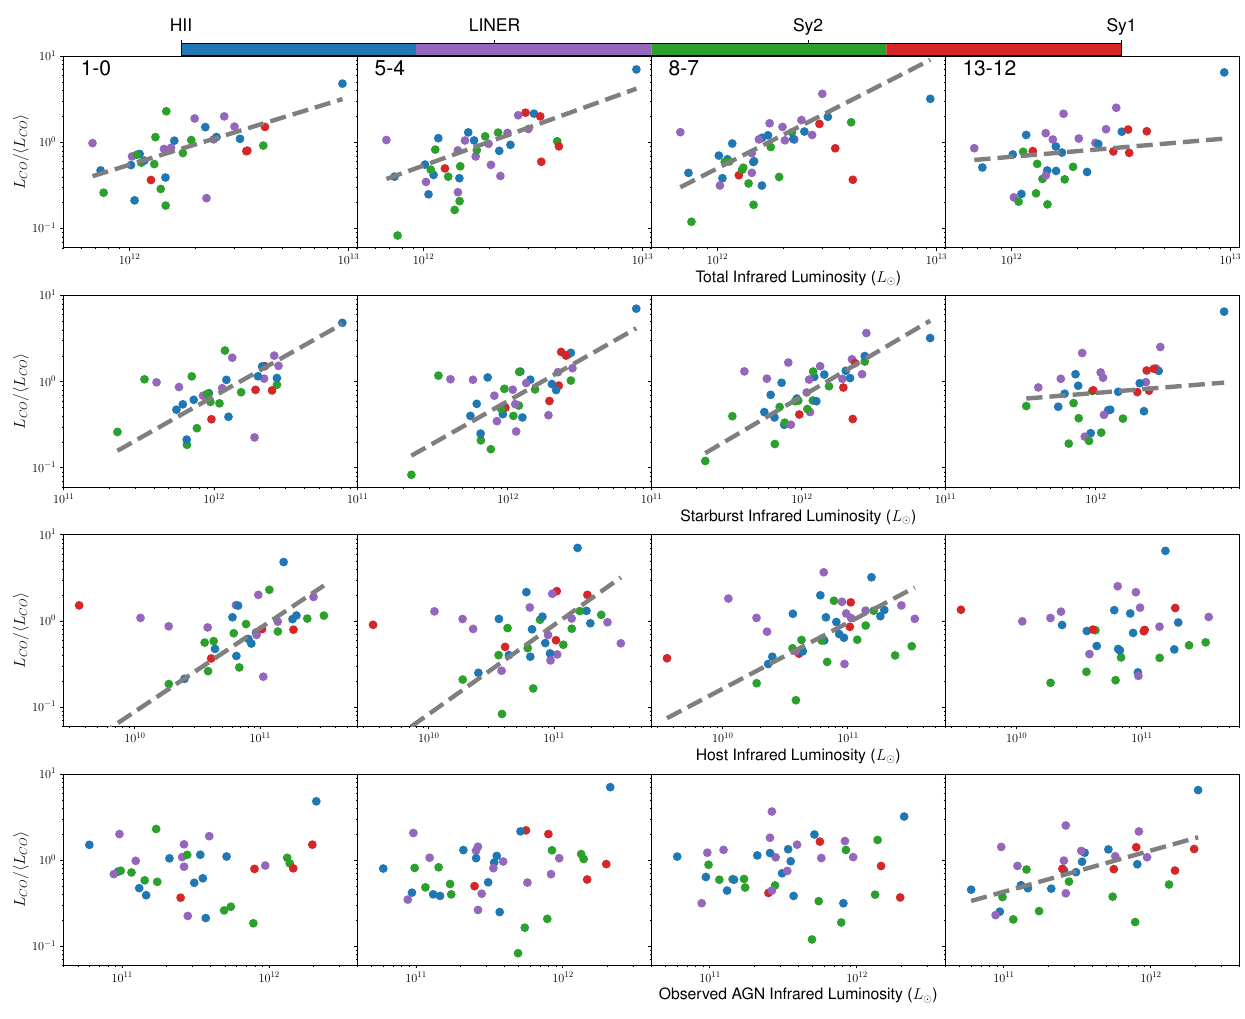
Figure 2. The slopes of the fits between CO luminosity and total, starburst, host, and AGN luminosity, using Equation (1) (Sections 3.1 and 3.2). The colors follow the Figure 1 legend.